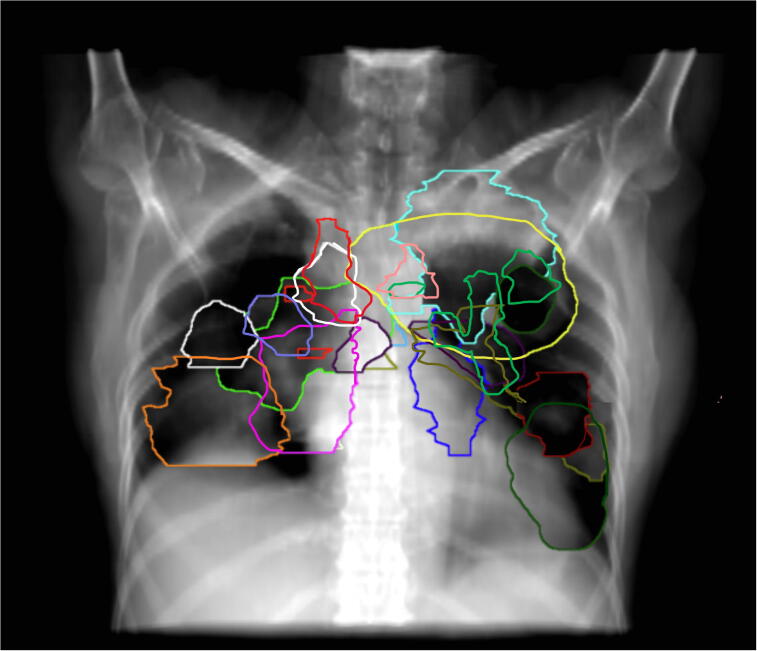
Coronal view of disease location of cases included in study.